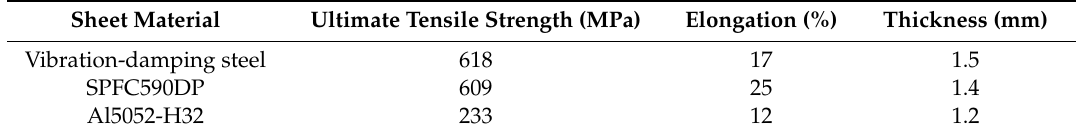
Figure 1. Cross-sectional view of the vibration-damping steel plate. Table 1. Tensile strengths and thicknesses of the materials used in this study.